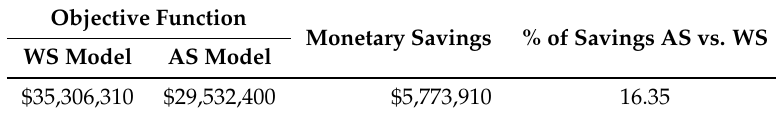
Table 10. Comparison between the solution cost for the AS model and the WS model for the case study instance.